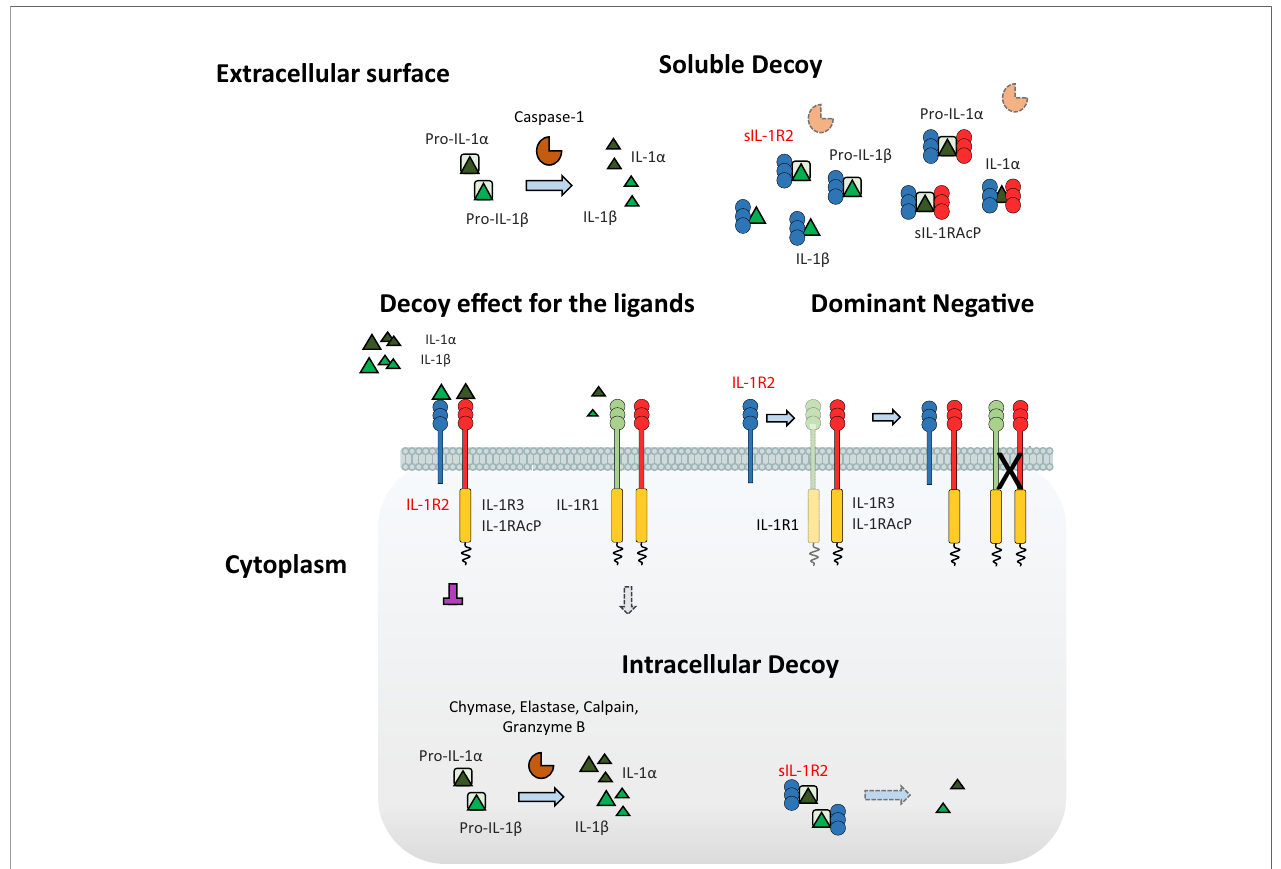
FIGURE 1 | Negative regulation of IL-1-mediated pathways by IL-1R2. IL-1R2 differs from the other ILRs for the absence of the characteristic intracellular TIR domain, thus being incapable of signaling. IL-1R2 in fl uences several mechanisms involved in the IL-1-mediated signaling cascade. IL-1R2 interacts with IL-1R3, acting as a dominant negative and impeding the formation of the IL-1R1//IL-1R3 signaling receptor complex; then, IL-1R2//IL-1R3 prevents the interaction between the ligands and the IL-1R1//IL-1R3 complex, by competitive binding to the pro-in fl ammatory cytokines IL-1 a and IL-1 b , thus acting as a decoy for the ligands. In addition, sIL-1R2 acts as a soluble decoy by binding IL-1 a and IL-1 b , as well as pro-IL-1 b , blocking its enzymatic cleavage by caspase-1. The interaction of sIL-1R2 with the soluble form of IL-1R3 further increases the af fi nity for the ligands. Finally, in cytosol soluble form, IL-1R2 regulates the pro-in fl ammatory activity of IL-1 a by preventing the enzymatic cleavage of pro-IL-1 a , acting as an intracellular